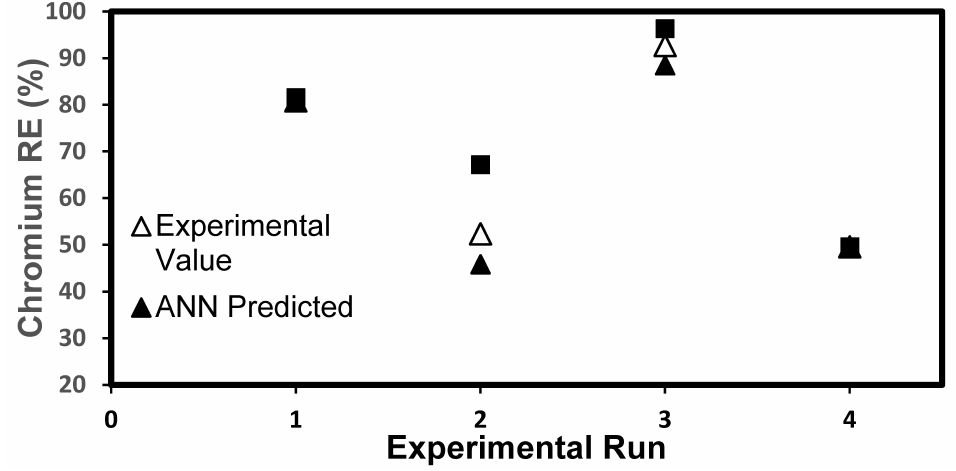
Figure 6. Experimental and predicted chromium (Cr) removal efficiencies of ANN and ANFIS models for the test